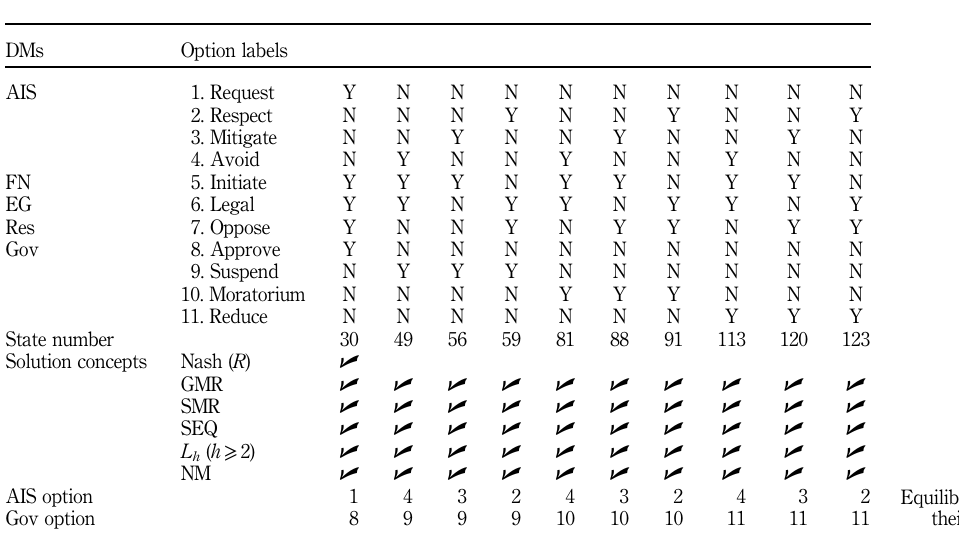
Table V. Equilibria states and